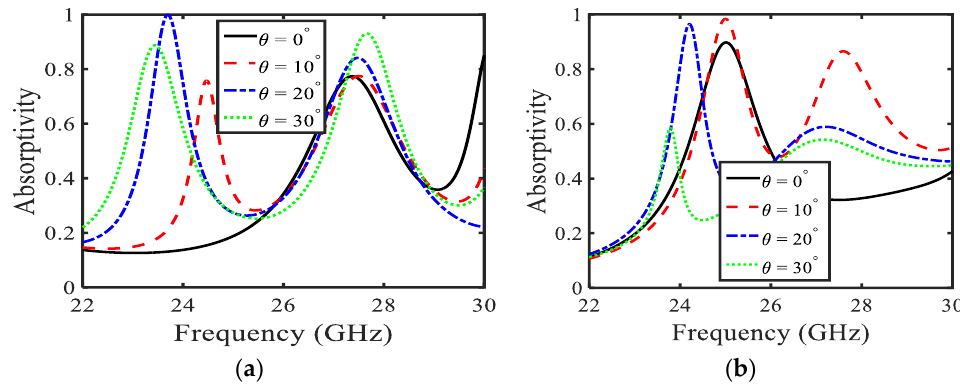
Figure 3. Absorption of the proposed MA keeping substrate thickness t = 1.2 mm for ( a ) TE polari- zation ( b ) TM polarization.